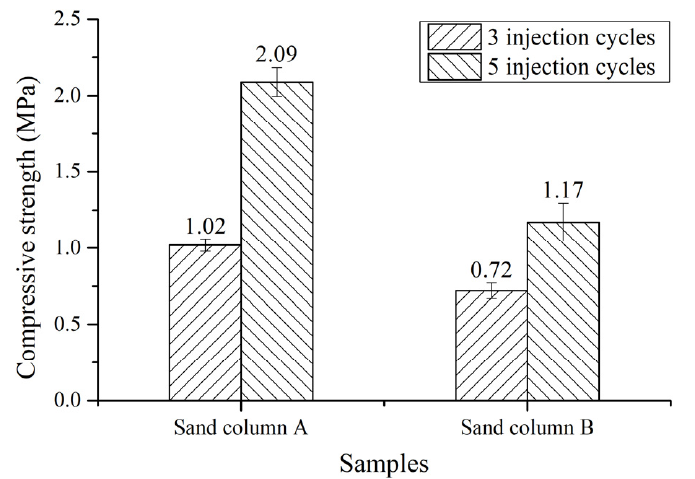
Figure 2. Compressive strength of the cemented sand columns.